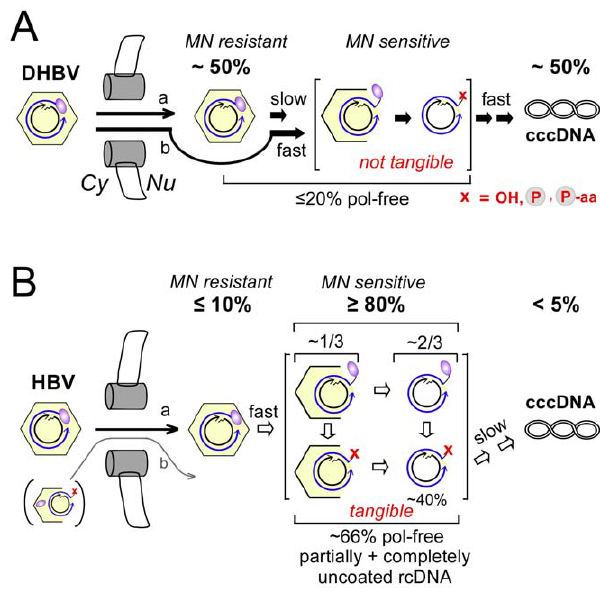
Figure 10. Virus-specific differences between DHBV and HBV cccDNA formation. The cartoon summarizes the steady-state levels of different rcDNA forms in human HepG2 cells transfected with surface- deficient viruses. They suggest specific steps that differentially affect the rate of cccDNA formation. Cytoplasmic rcDNA of both viruses was largely present in intact nucleocapsids, with , 10% in protein-free form. The about four-fold higher nuclear import efficiency of DHBV vs. HBV nucleocapsids is not considered. The red x indicates absence of intact polymerase; the minus-strand 5 9 end may consist of a hydroxyl (OH) or phosphate (encircled P) group, or still contain one or more amino acid residues (aa) from the polymerase. ( A ) DHBV. Nuclei contained , 50% rcDNA plus , 50% cccDNA. Most of the rcDNA was present in MN resistant, i.e. bona fide intact, capsids. The fraction of protein-free rcDNA in the nucleus ( , 20%) was only modestly higher than in the cytoplasm. If stably encapsidated nuclear rcDNA is a precursor to cccDNA (a), uncoating is the only slow step. If stable intranuclear capsids are a dead-end product nuclear import is rate-limiting. ( B ) HBV. Nuclei contained # 10% MN resistant full-length rcDNA and ,